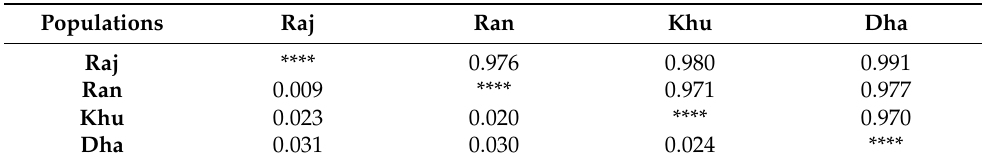
Table 8. Pair wise comparisons of genetic identity and genetic distance among the four C. falcatum populations based on ISSR markers.